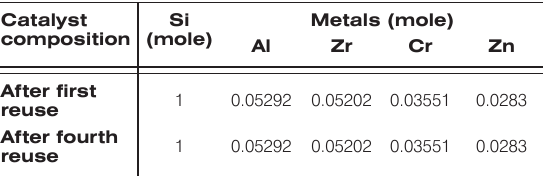
Table 4. Catalyst composition after the first and the fourth reuse. Catalyst